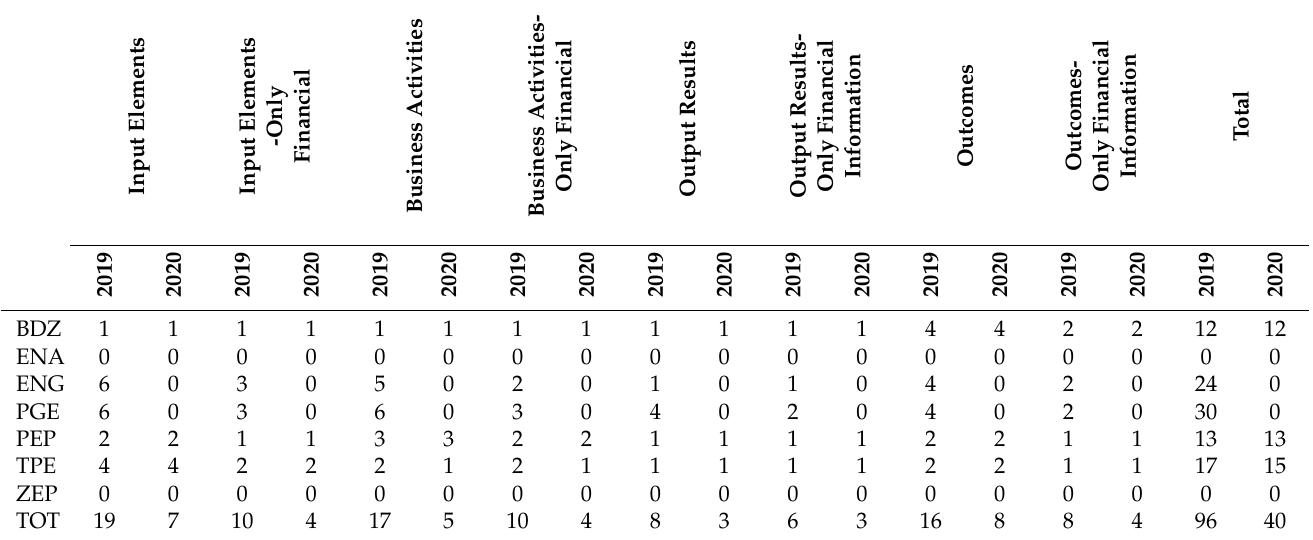
Table 3. The number of disclosures on components of the business model of companies in the energy